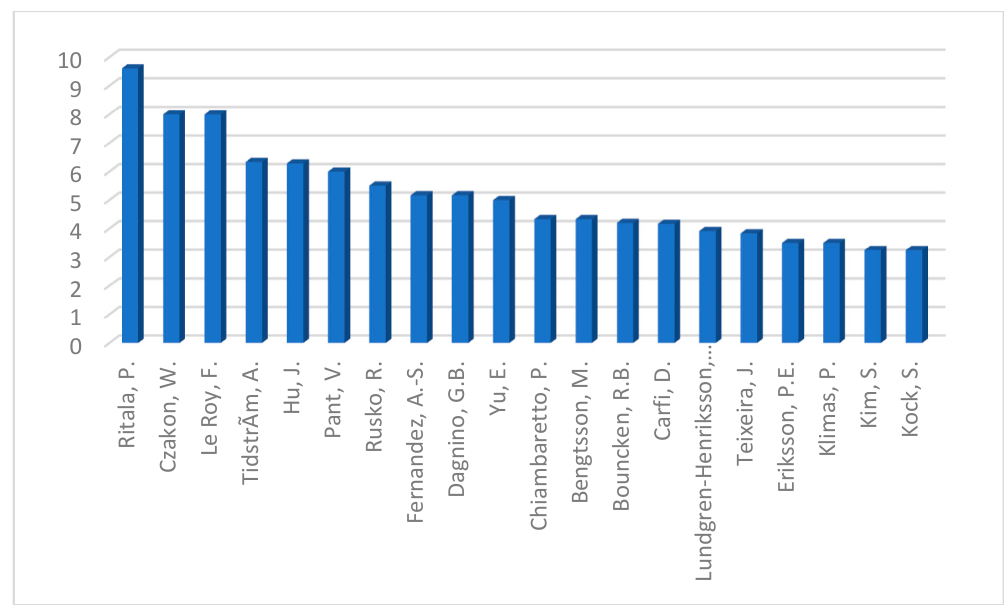
Figure 4. The top 20 contributing authors in the area of coopetition (Scopus Database), fractional counting (constructed via BibExcel), N = 664 papers.